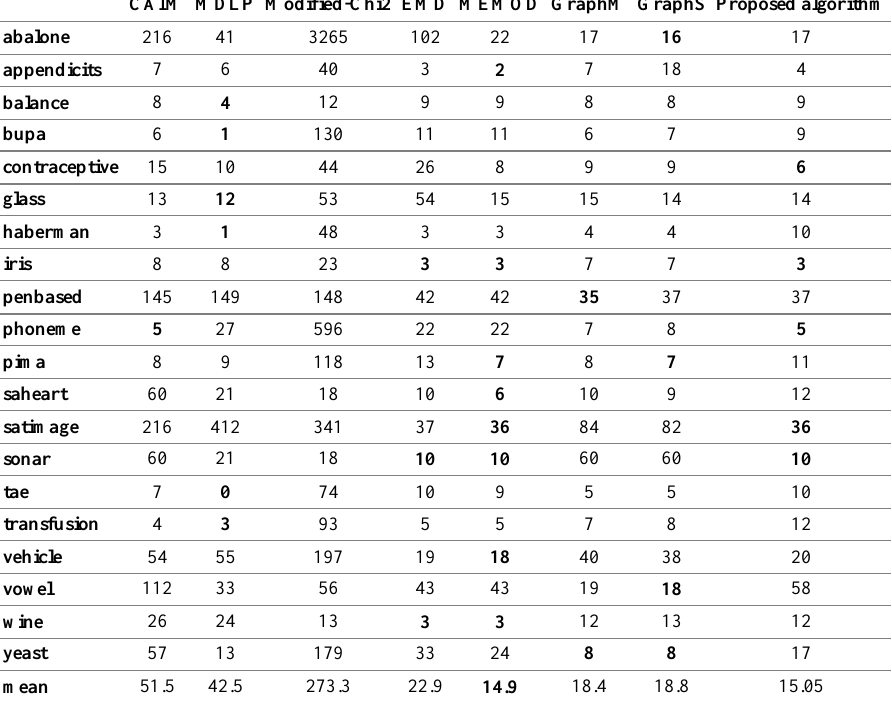
Table 4. The number of cut points obtained by algorithms.